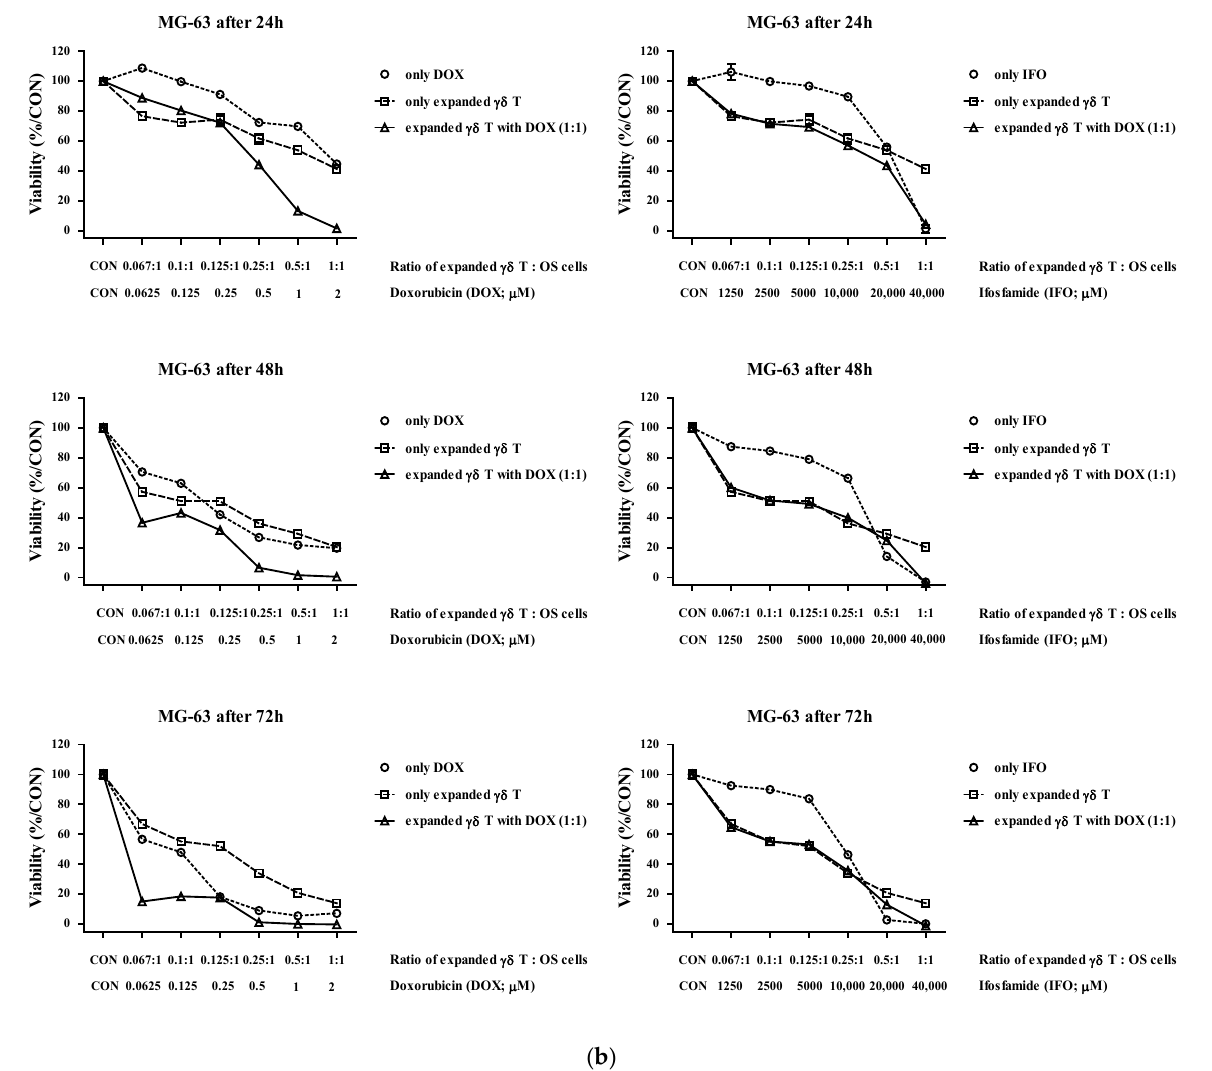
Figure 5. Combined cytotoxicity of anticancer drugs and expanded γδ T cells against osteosarcoma (OS) cells in vitro 24 h prior to drug treatment, KHOS/NP ( a ) and MG-63 ( b ). OS cells were pretreated with expanded γδ T cells. Cytotoxicity and cell viability were measured using the EZ-CyTox cell viability assay kit after 24, 48, and 72 h, and the percentages are represented as the mean ± SEM. Table 1. Combination Index (CI) values of the interaction between expanded γδ T cells with DOX against osteosarcoma (OS) cells.